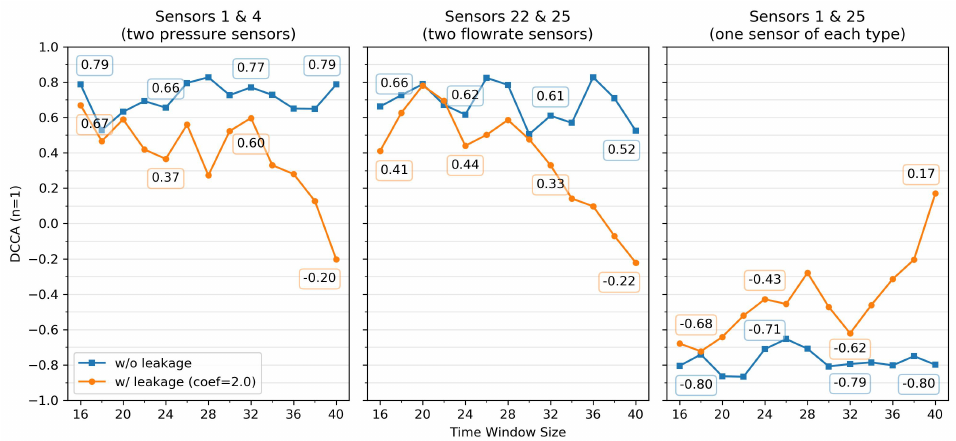
Figure 13. Impact of time window size on DCCA in three selected pairs from chunk